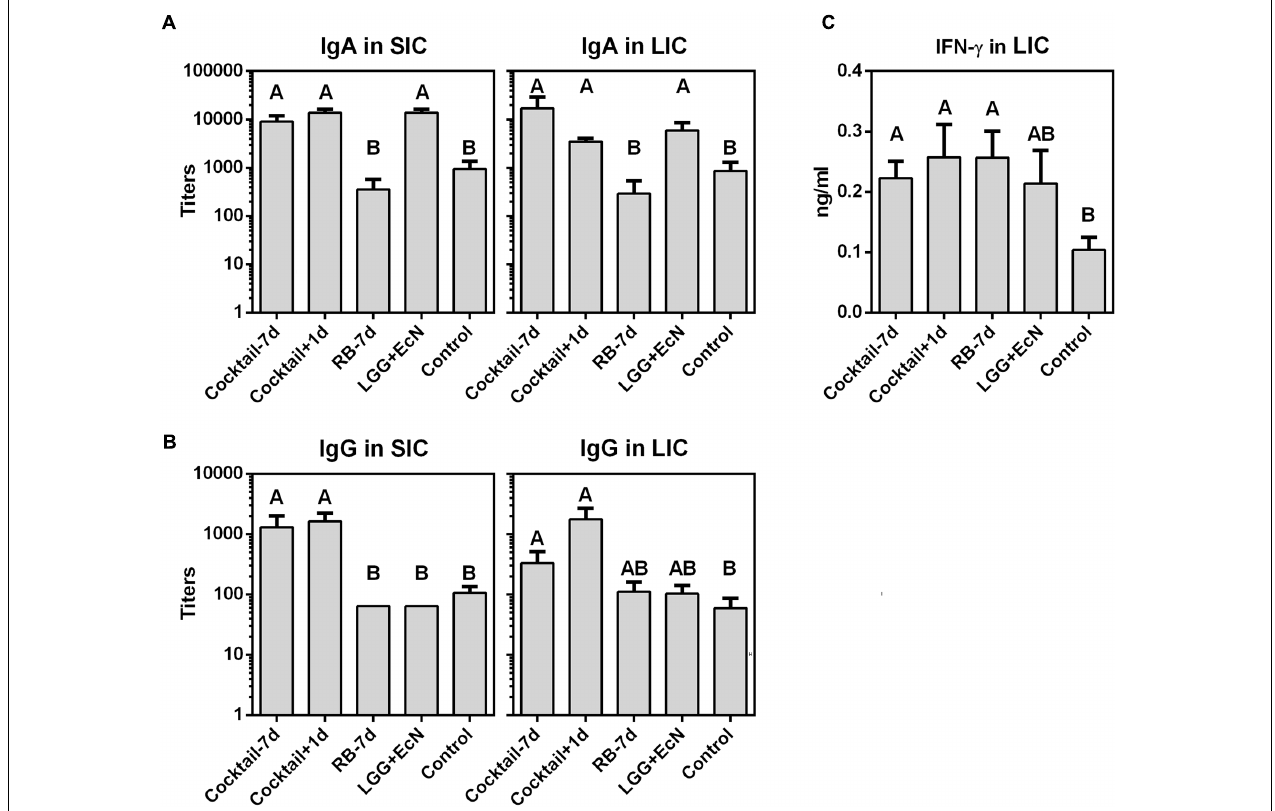
FIGURE 5 | IgA, IgG, and IFN- γ levels in intestinal contents after HuNoV infection. Total IgA (A) and IgG (B) titers in small and large intestinal contents (SIC and LIC) were measured by ELISA. (C) IFN- γ concentration in LIC was measured by ELISA. Sample sizes are shown in Table 1 . Data are presented as mean ± SEM. Statistics were determined by Kruskal–Wallis test. Different letters indicate significant differences among groups ( P < 0.05), while shared letters indicate no significant